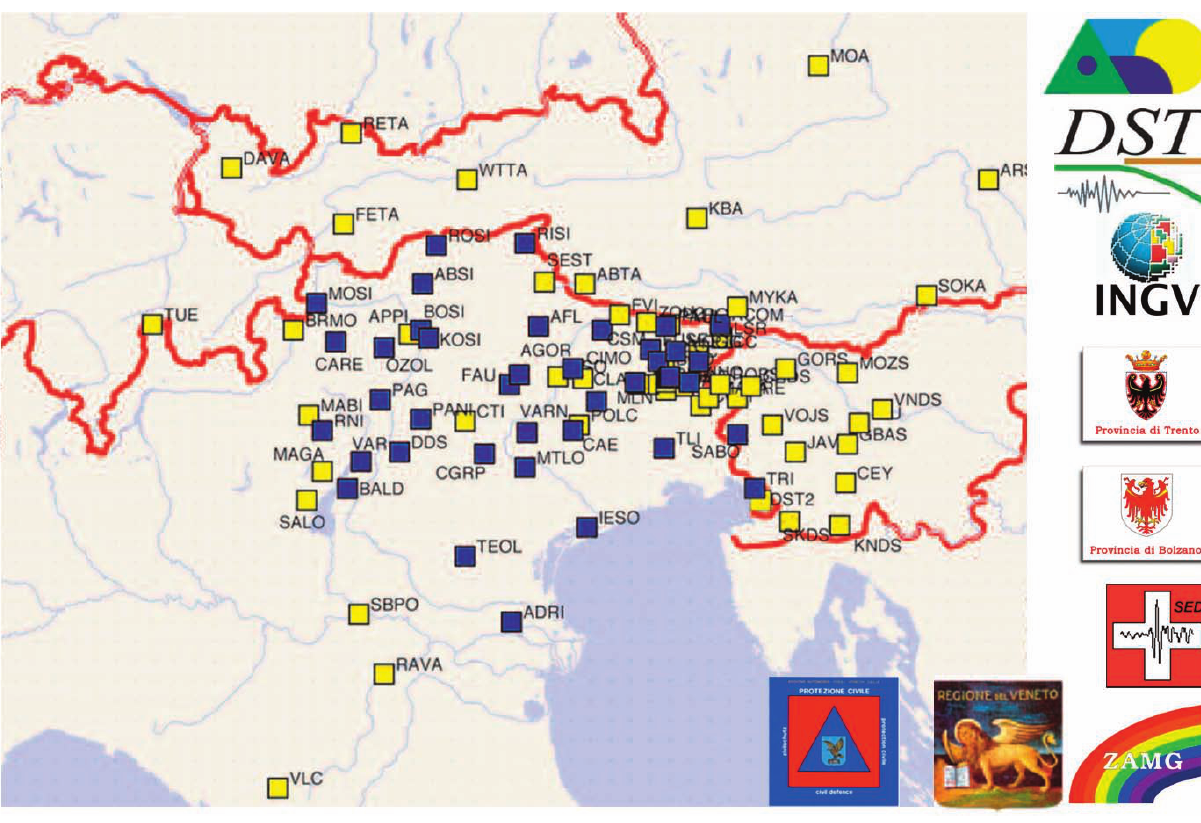
Figure 2. Map of the real-time seismic stations of the OGS-CRS.